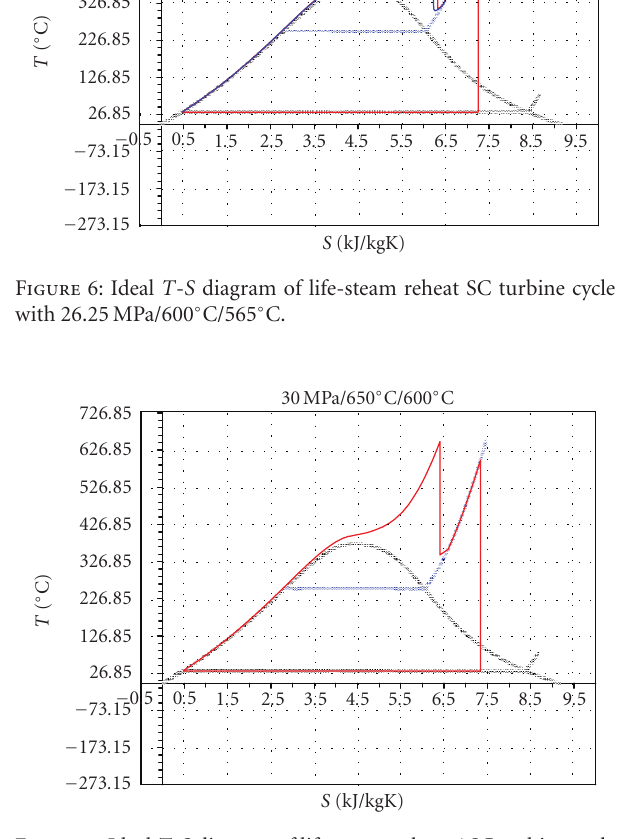
Figure 7: Ideal T - S diagram of life-steam reheat ASC turbine cycle with 30 MPa/650 ◦ C/600 ◦